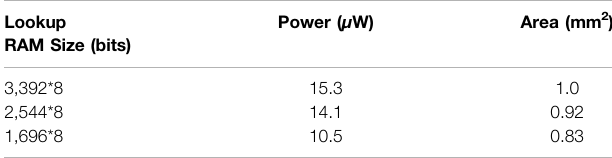
TABLE 6 | Summary of power consumption and footprint of a single FSM or lookup